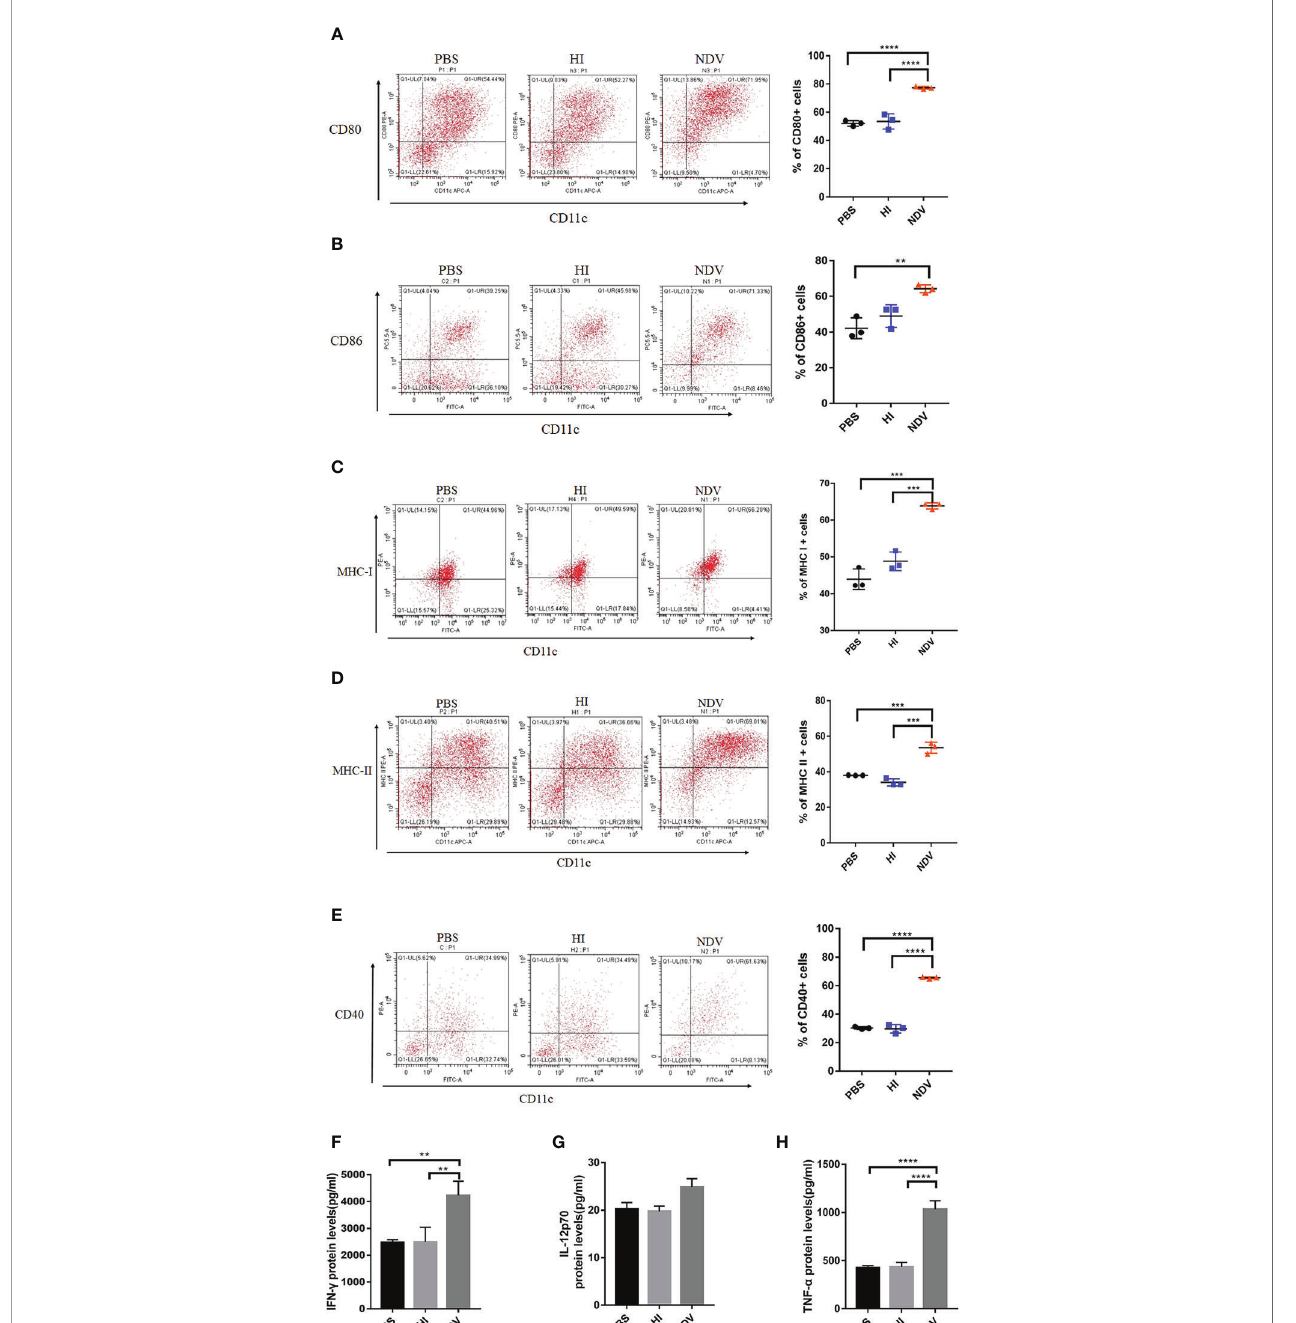
FIGURE 1 | Maturity of DCs mediated by NDV. DCs isolated from murine bone marrow were cultured for 7 days and treated with PBS (mock), HI or NDV at 3 MOI for 48 h respectively. Then fl ow cytometry was performed to analyze the proportions of CD80 (A) , CD86 (B) , MHC-I (C) , MHC-II (D), and CD40 (E) expressing DCs. Supernatants of treated DCs were harvested to measure secretion of IFN- g (F) . IL-12p70 (G) TNF- a (H) . All experiments were performed independently at least thrice and results were presented as means ± standard deviation. Signi fi cance levels were de fi ned as **p < 0.01, ***p < 0.001 and ****p <